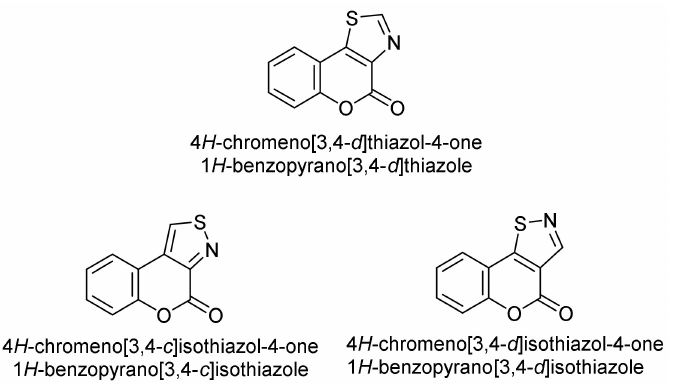
Figure 3. The common three isomers of fused the thiazole and isothiazole ring to the α -pyrone moiety of the